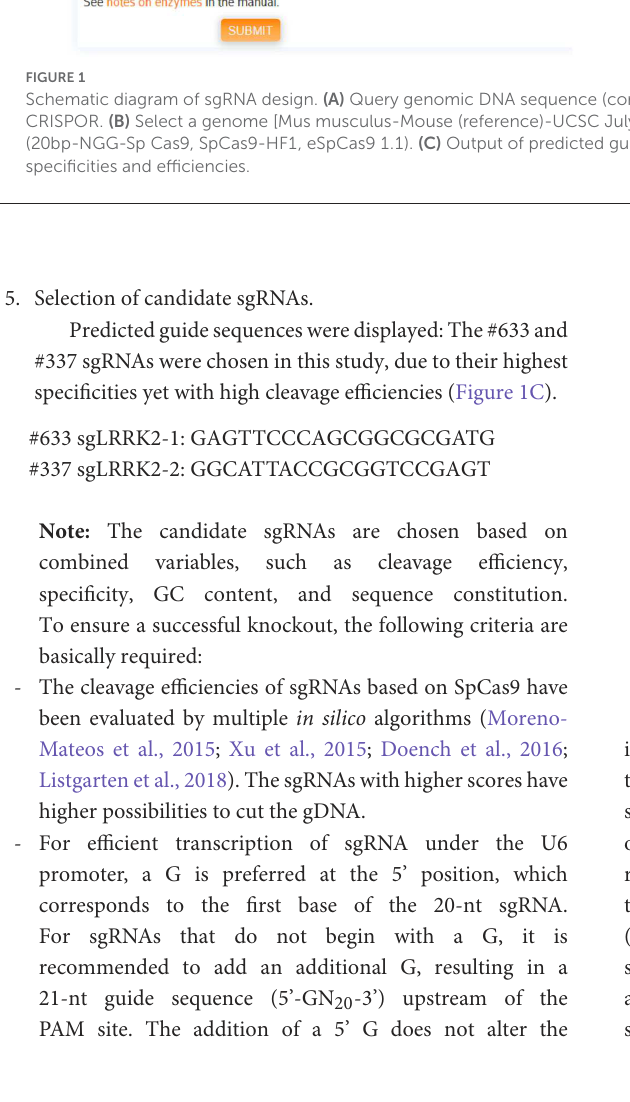
5. Selection of candidate